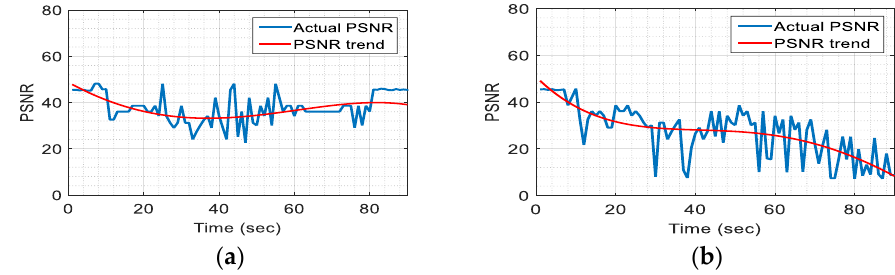
Figure 11. PSNR (in dB): ( a ) Full image and ( b ) partitioned image. Technologies 2019 , 7 , 67